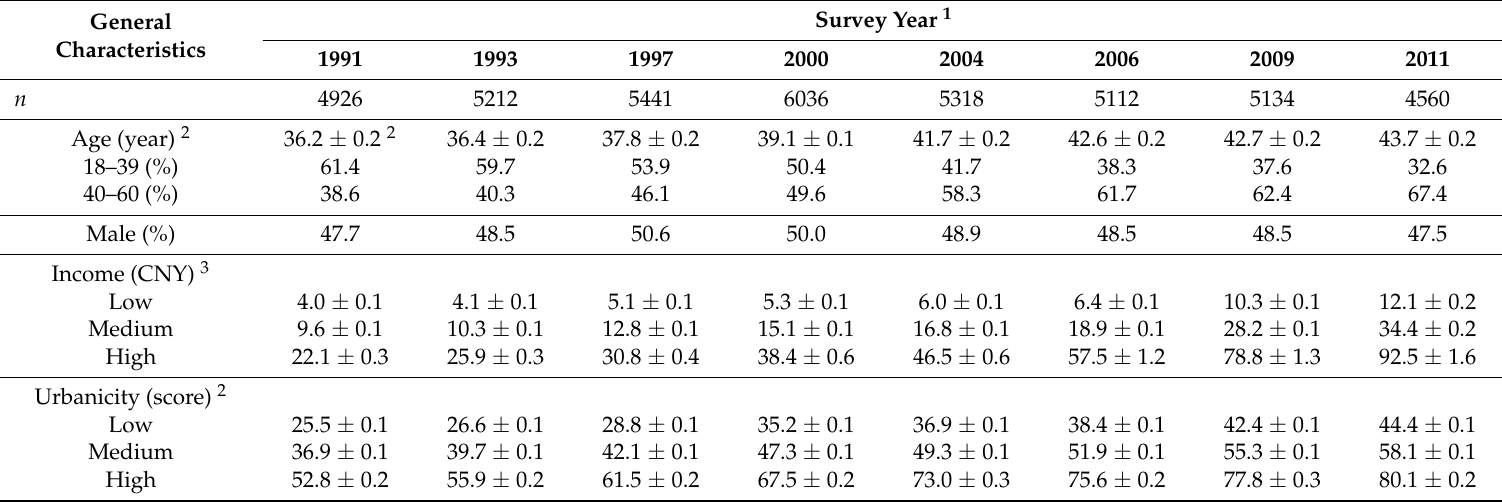
Table 1. General characteristics of participants aged 18–60